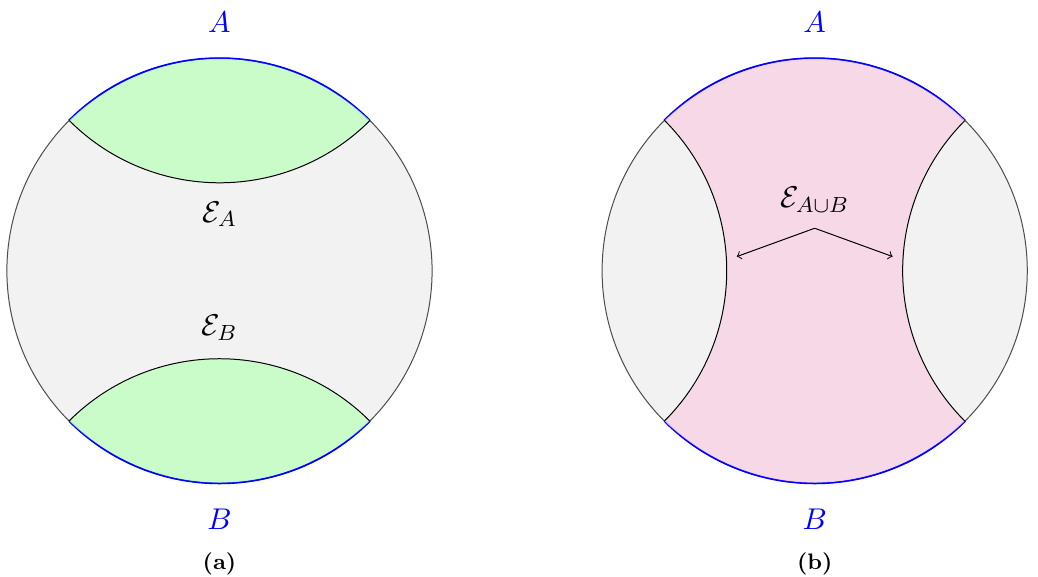
Figure 1 . Phase transition in the HRT surface and corresponding entanglement wedge (whose spatial slice is indicated by the shaded homology region R AdS . (a) Shows the decorrelated phase, while (b) shows the correlated phase. When A and B 3 each take up one quarter of the boundary length, the surfaces E